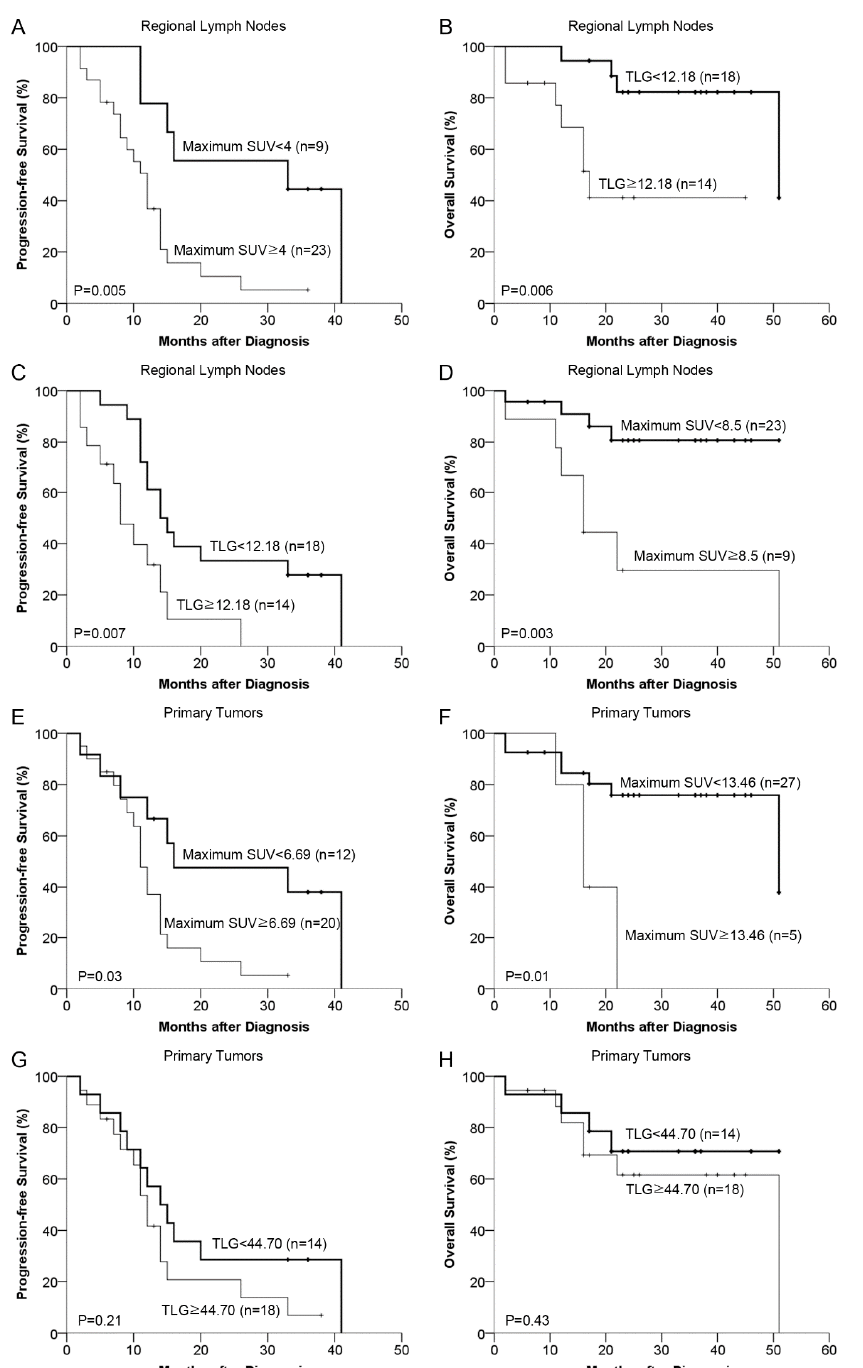
Figure 4. Kaplan-Meier estimates of survival according to 18 F-FDG uptake. Based on multivariate cox regression analysis, progression-free survival ( A ) and overall survival ( B ) are shown for two subgroups dichotomized according to the maximum standardized uptake value (SUV) and total lesion glycolysis (TLG) of regional lymph nodes, respectively. The cutoff points for the maximum SUV and TLG of regional lymph nodes were 4.00 and 12.18 (the exponential of 2.5), respectively. Other possible combinations are also shown for comparison ( C – H ). The cutoff points were 12.18 (the exponential of 2.5), 8.5, 6.69 (the exponential of 1.9), 13.46 (the exponential of 2.6), 44.70 (the exponential of 3.8) and 44.70, respectively. Tick marks indicate times of